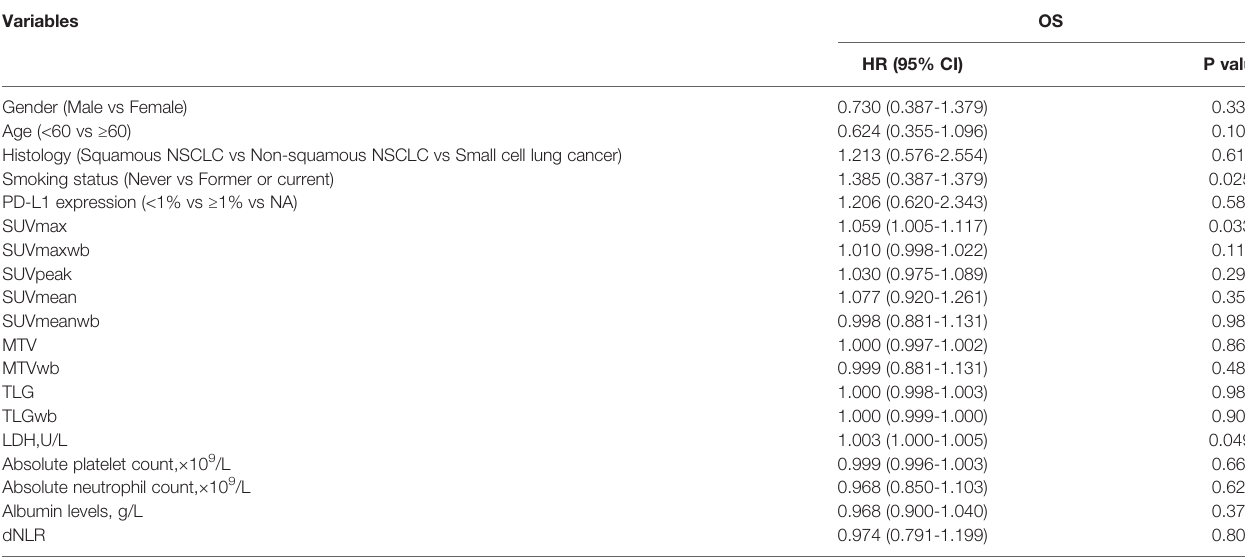
TABLE 4 | Univariate analysis of overall survival in all patients.